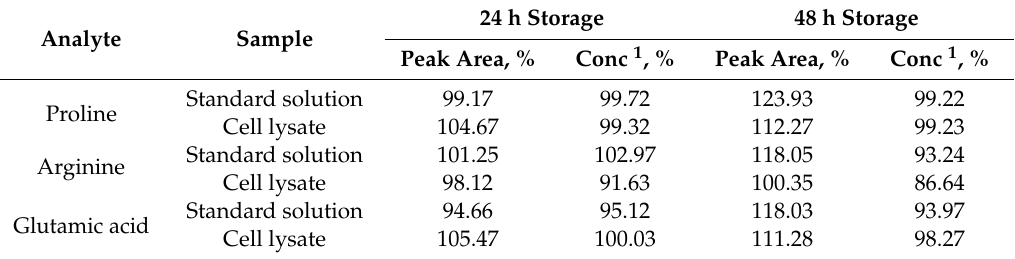
Table 3. Results of post-preparative stability tests of target